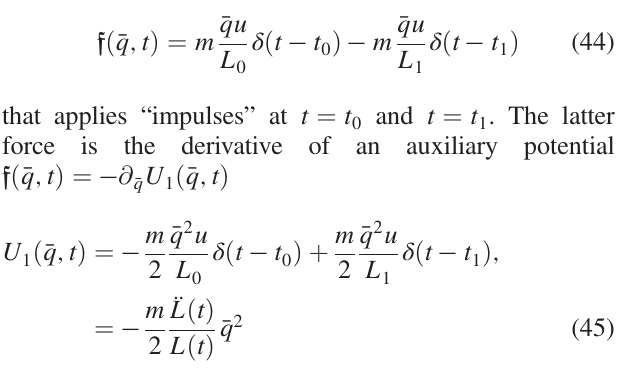
ffiffiffiffiffiffiffiffiffiffi 2 mE